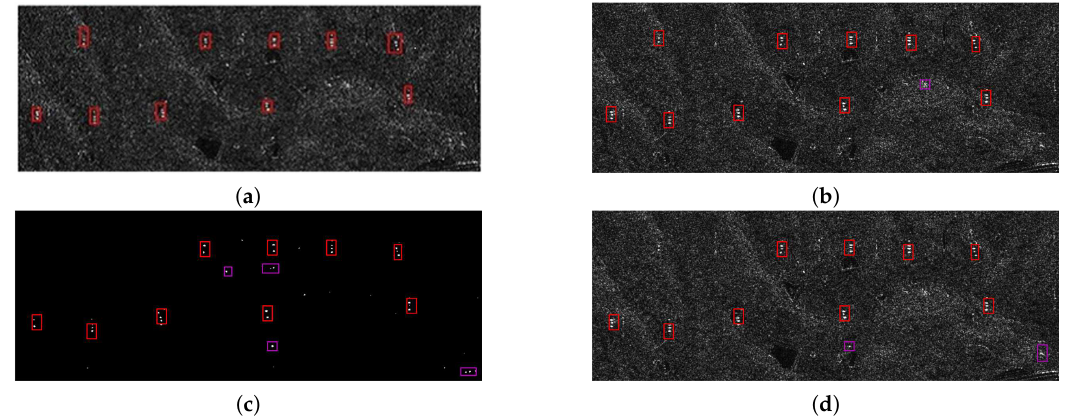
Figure 9. Target-detection results using different algorithms. ( a ) original image; ( b ) MSDMC model; ( c ) global scattering center model; and ( d ) region-based model. Table 6. Target-detection results on the Enshi data set using different methods.